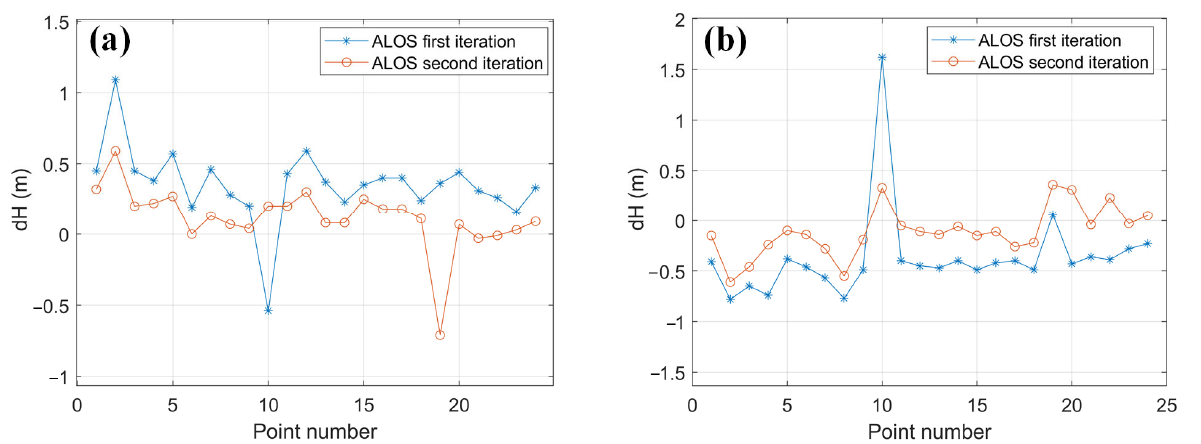
GF-7 laser beam 1 and beam 2 after the iterative calibration, Tables 4 and 5 are presented graphically in Figure 8.